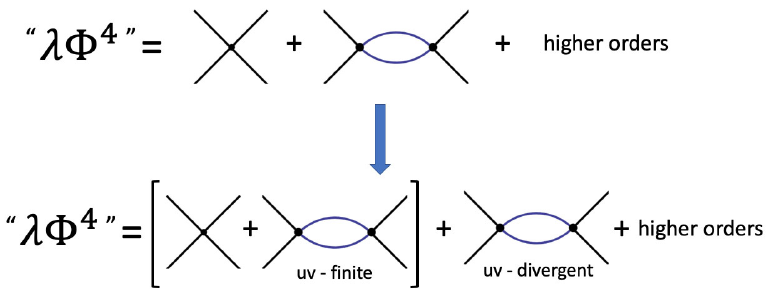
Figure 1. The re-arrangement of perturbation theory introduced by Stevenson [8]. The quanta of the symmetric phase with physical mass m R , besides the contact + λδ 3 ( r ) repulsion, also feel a − λ 2 e − 2 rmR attraction from the Fourier transform of the ultraviolet-finite part of the 1-loop diagrams [5]. Its range diverges in the m R → 0 limit so that, below a critical mass m c , the attraction dominates by inducing